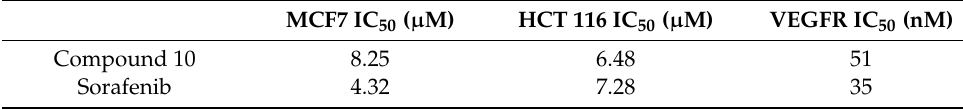
Figure 15. VGFER-2 prohibition and cytotoxicity of compound 10 . Table 4. VGFER-2 prohibition and cytotoxicity of compound 10